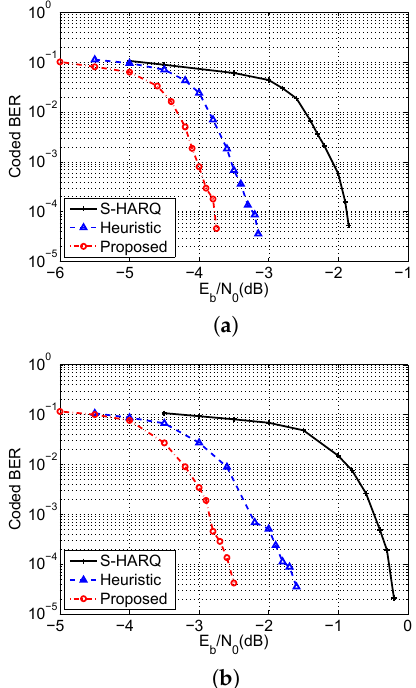
Figure 4. Monte-Carlo simulated coded BER with ( a ) 16-QAM, ( b ) 32-QAM.